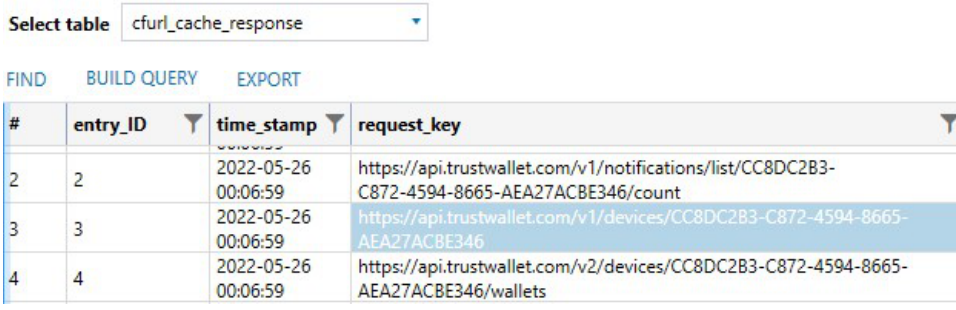
Figure 14. Trust Wallet device ID within one of the HTTPS